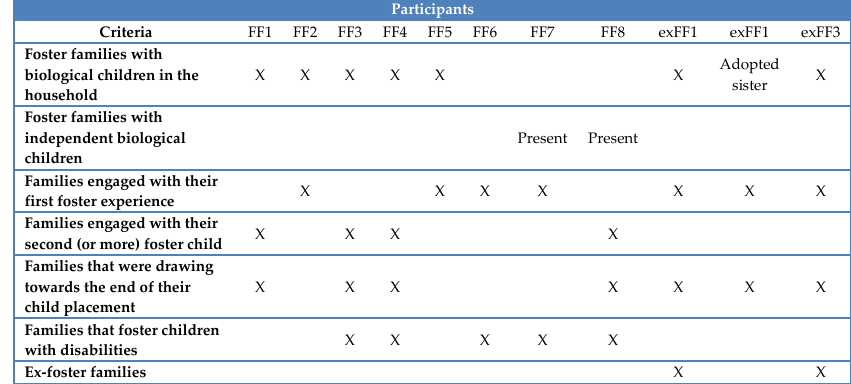
Table 1. Map of Participants. Figure 1. Map of